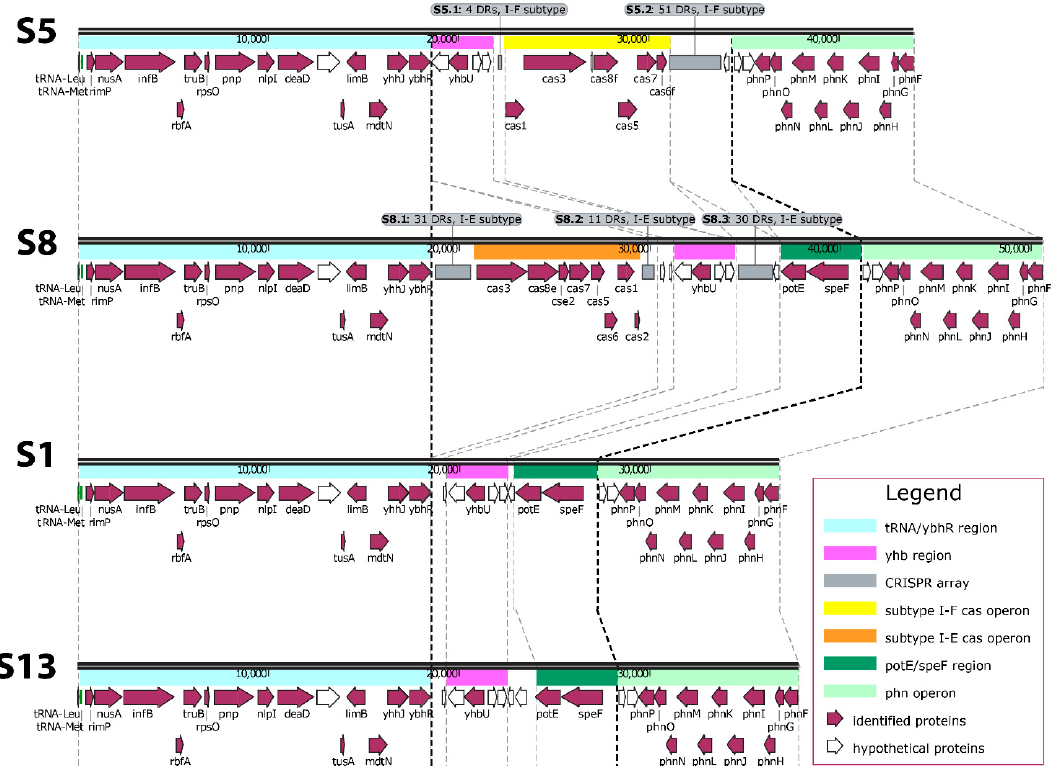
Figure 1. Comparative analysis of the genomic region extending from the gene for tRNA Leu to phnF in S1, S5, S8, and S13. The region was labelled both by automatic Prokka annotation and manual editing. Dashed lines follow the corresponding region among strains. Bold dashed lines delimit the variable domain. The array code, number of direct repeats, and CRISPR subtype are reported in the grey flags on the top of the corresponding CRISPR array. Genes and open reading frames are represented by arrow boxes pointing in the direction of transcription. Feature names are labelled below the arrow